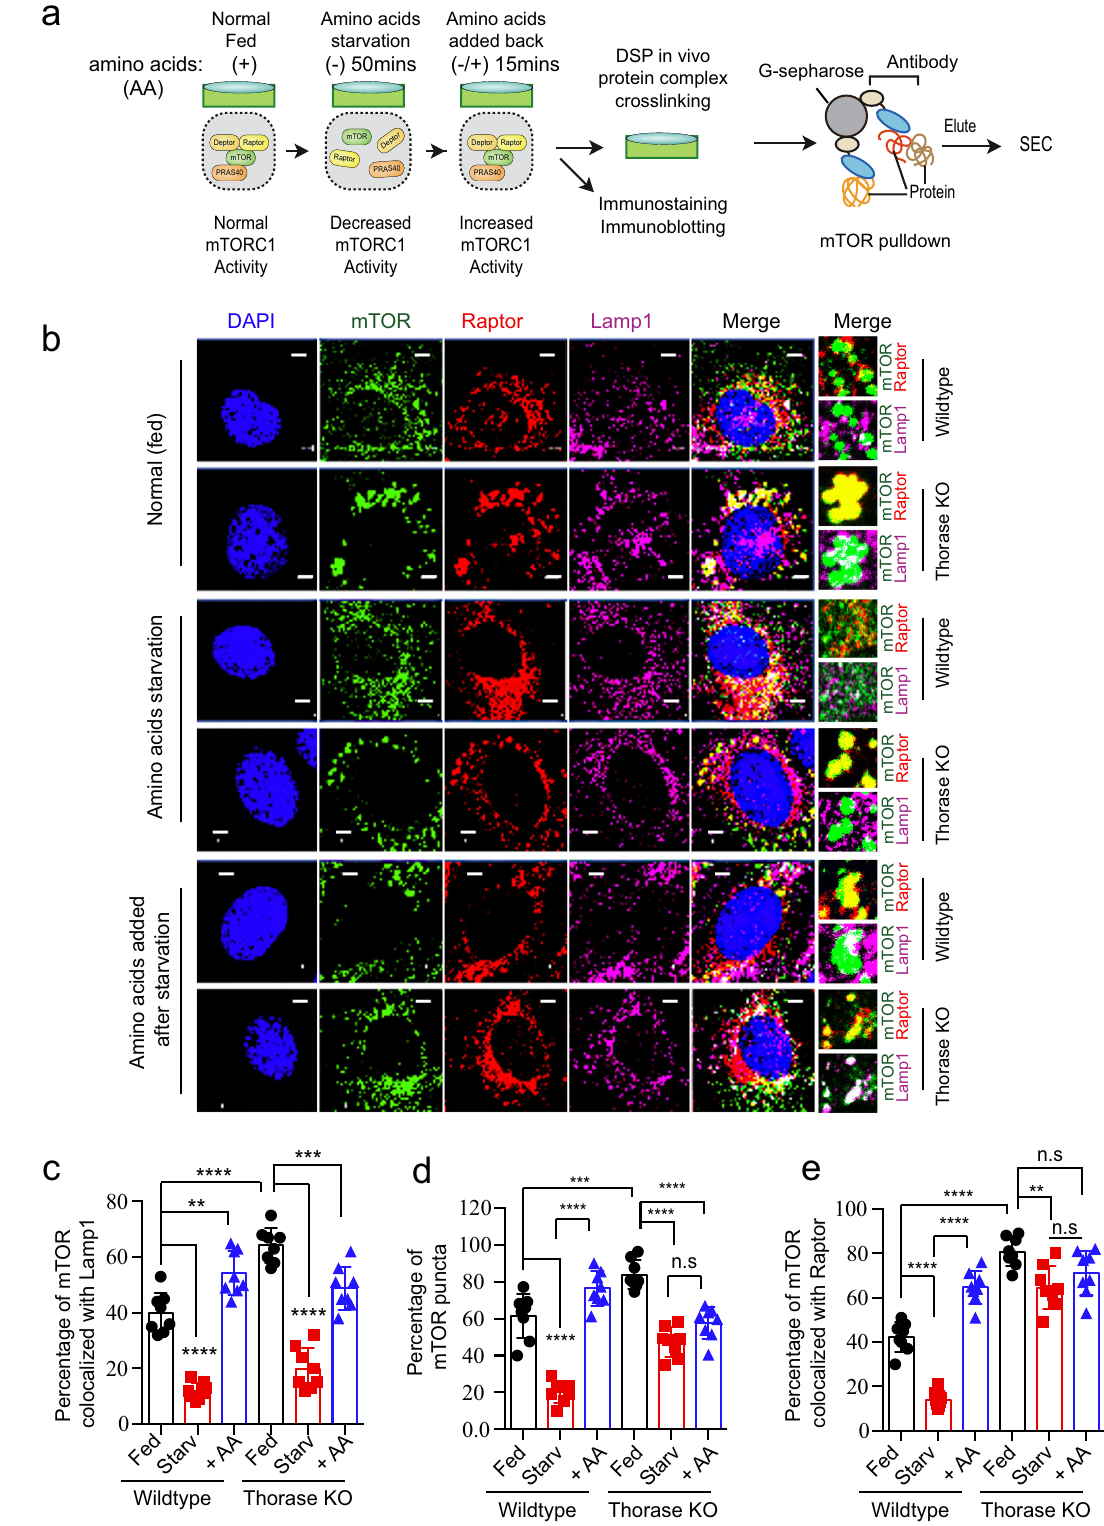
Fig. 5 | Thorase modulates mTOR interaction withRaptor for activation atthe lysosomes by amino acids. a A schematic diagram depicting the protocol for analysis of Thorase-mTOR-Raptor complexes under different nutrient status in MEFs. b Representative images of wild type and Thorase KO MEFs under different nutrientstatusshowingmTOR-RaptorandmTOR-Lamp1co-localization.Scalebars are 5 μ m. c Quanti fi cation of mTOR-Lamp1 colocalization of images in b ( n =8